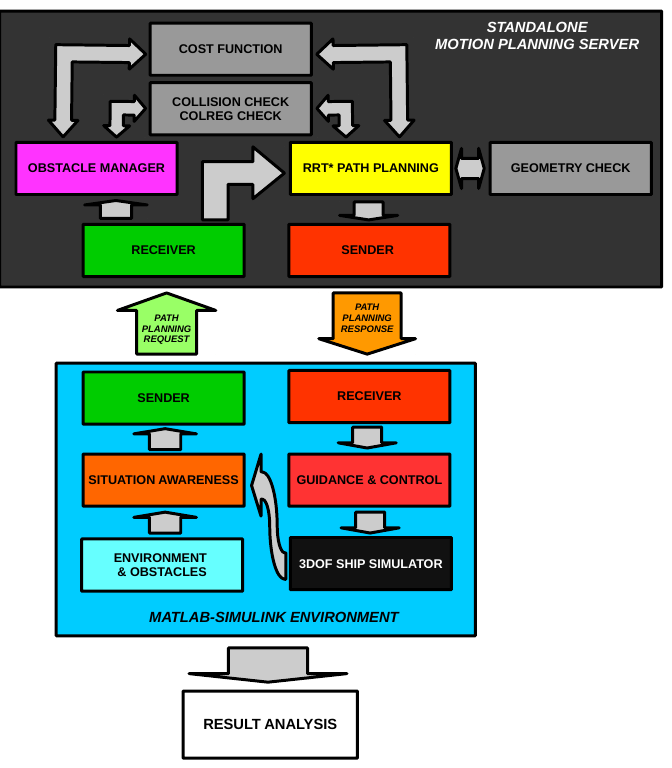
Figure 6. The implemented testing